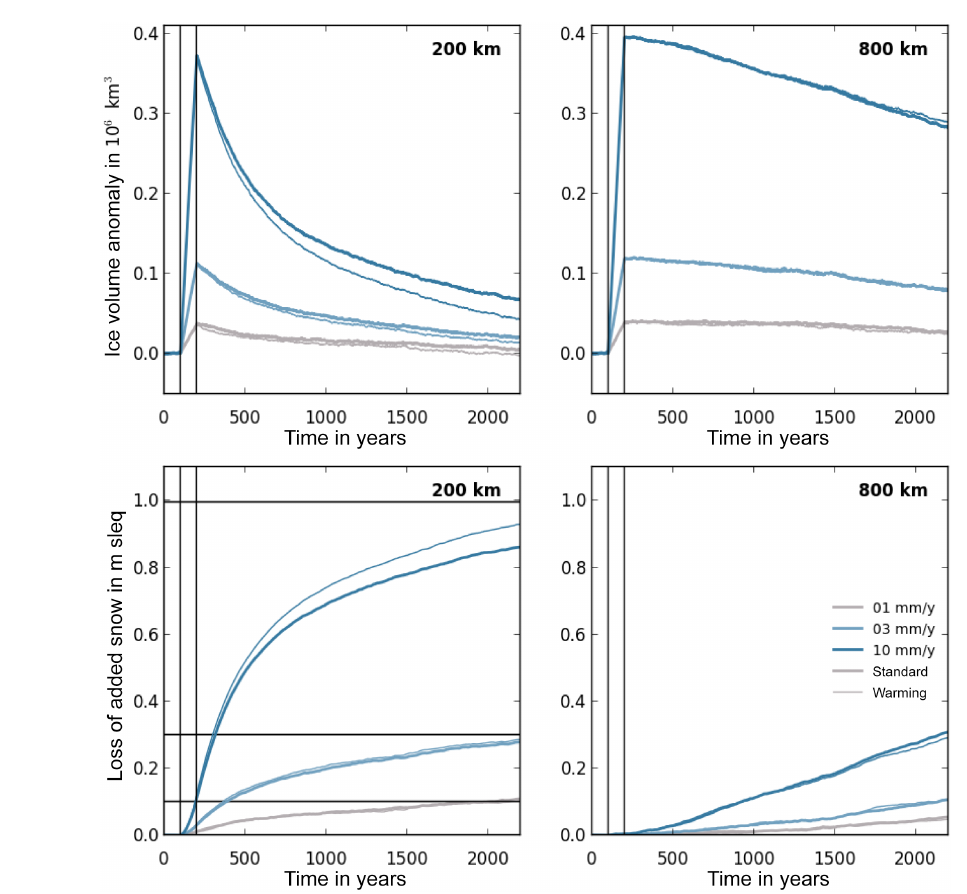
Figure 4. Response of the Antarctic ice sheet to a 100-year surface-mass addition. Ice volume gain and relaxation (upper panels) and equivalent loss of the added snow (lower panels) for the close-to-coast (200km, left panels) and farthest-inland (800km, right panels) simulations for the 1, 3, and 10mmyr − 1 mitigation cases (grey, light blue, and dark blue colors). Thick lines indicate simulations without surface warming, thin lines with surface temperature held at seawater freezing point during the forcing (upper bound). Vertical lines indicate the pulse interval, and horizontal lines in lower left panel indicate the total ice volume